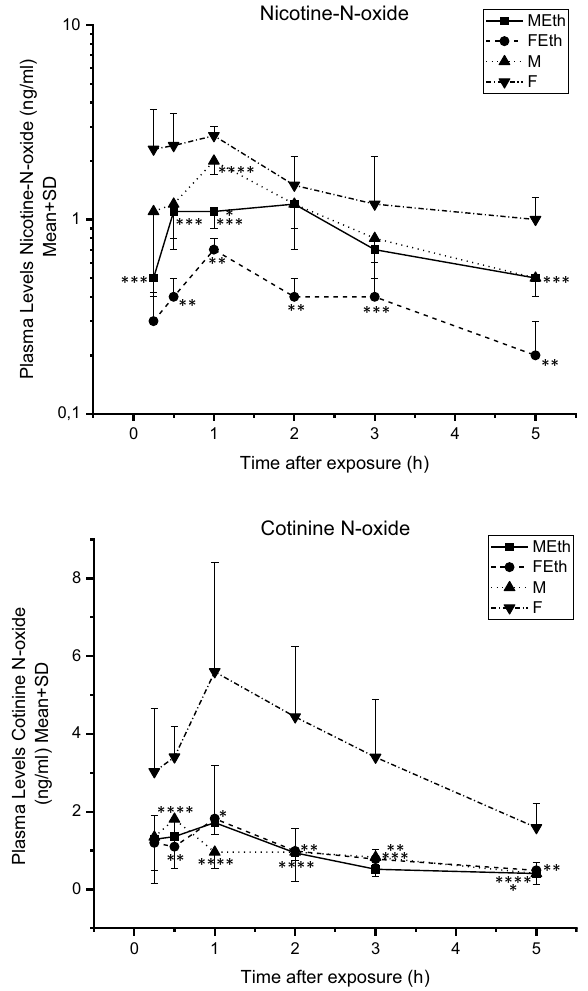
Figure 4. Plasma nicotine-N-oxide and cotinine-N-oxide levels measured over time—rats exposed to tobacco smoke at a concentration, expressed as carbon monoxide, 1500 mg CO/m 3 for 5 days, 6 h a day. Asterisks indicate a significant difference value (P < 0.05): *MEth vs M, **FEth vs F, ***MEth vs FEth and ****M vs